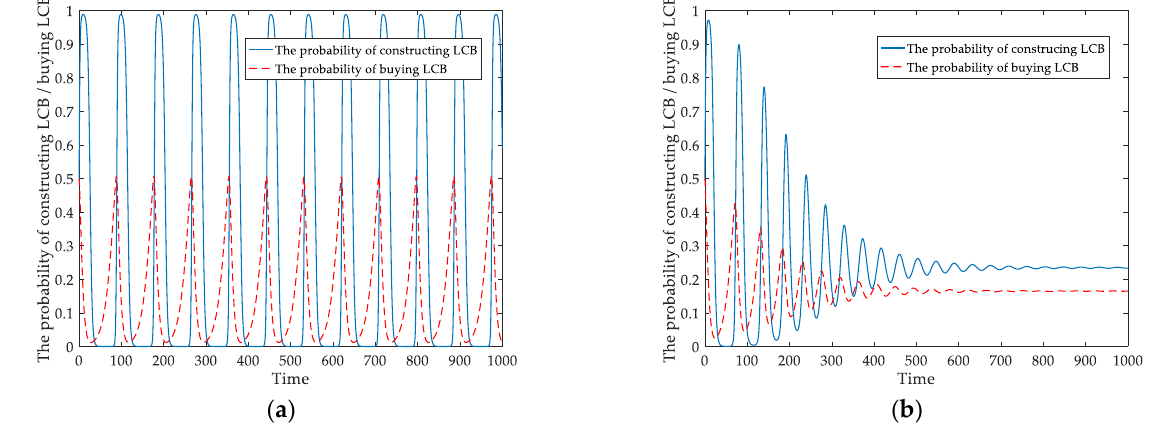
Figure 8. Players’ behaviors in an evolutionary game ( a ) with a static carbon tax ( b ) with a dynamic carbon tax